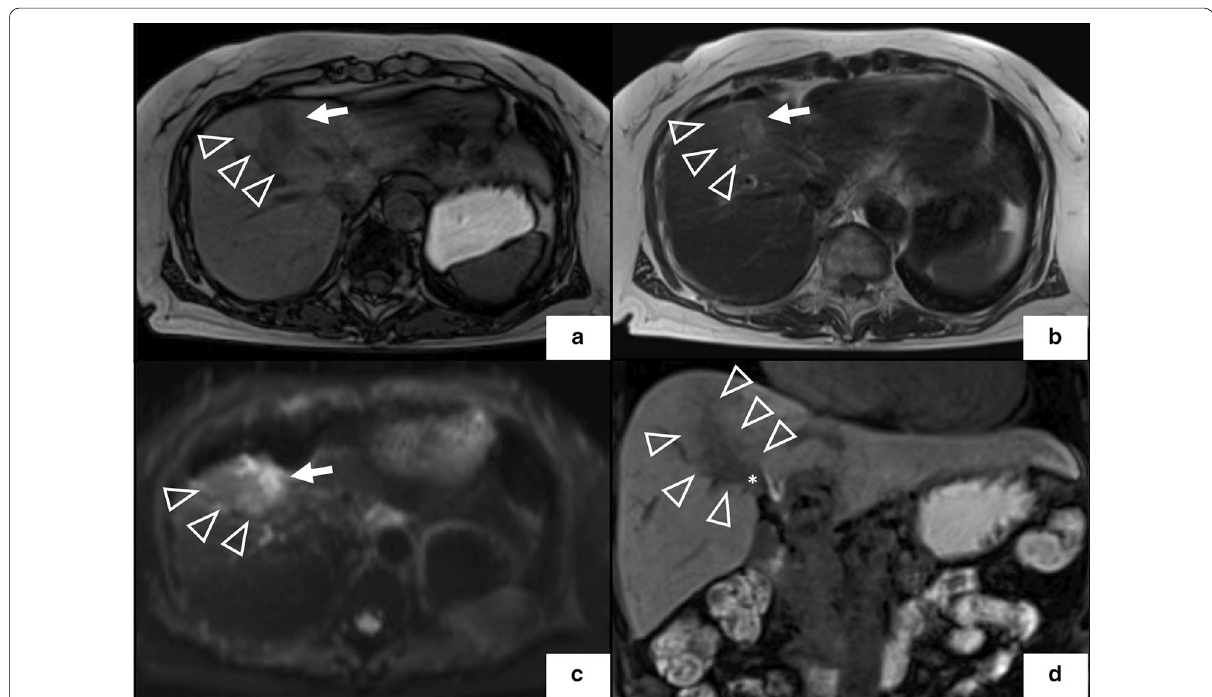
Fig. 2 Preoperative magnetic resonance imaging findings. The tumor (arrow head) adjacent to the scar of radiofrequency ablation (arrow) exhibits low intensity on the T1-weighted image ( a ) and a slightly high intensity on T2- ( b ) and diffusion-weighted images ( c ). d Hepatobiliary phase of sagittal scan shows a low-intensity mass (asterisk) that continued from the tumor into the right hepatic duct